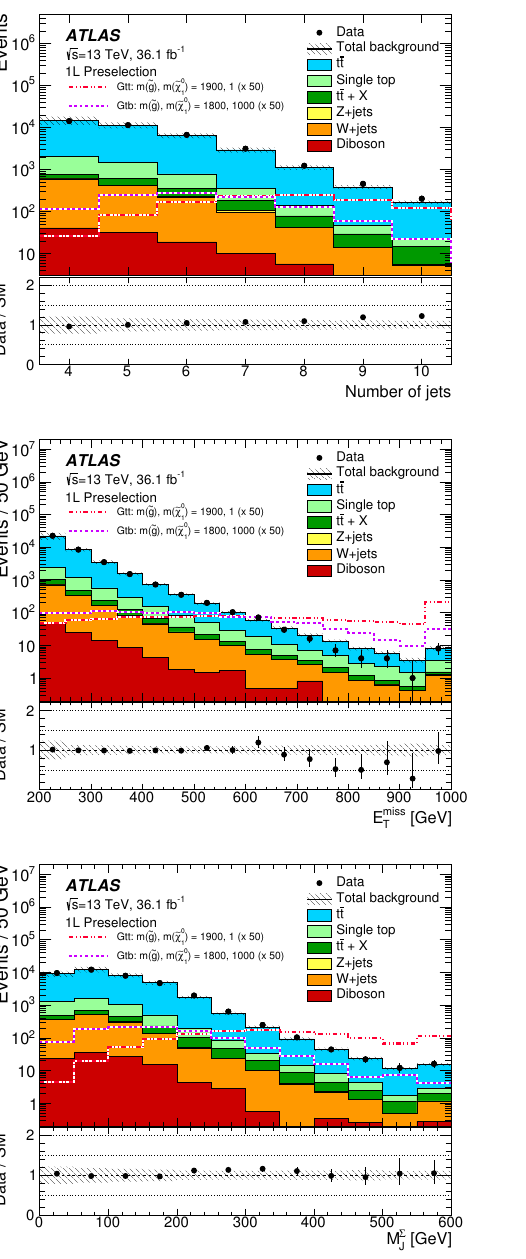
Figure 4. Distributions of (top-left) the number of selected jets ( N jet ), (top-right) the number of selected b -tagged jets, (centre-left) E miss , (centre-right) m e(cid:11) , (bottom-left) M (cid:6) and (bottom-right) J T m T for events passing the 1-lepton preselection criteria, after applying the kinematic reweighting to the m e(cid:11) distribution described in the text. The statistical and experimental systematic uncertainties (as de(cid:12)ned in section 7) are included in the uncertainty band. The last bin includes over(cid:13)ow events. The lower part of each (cid:12)gure shows the ratio of data to the background prediction. All backgrounds (including t (cid:22) t ) are normalised using the best available theoretical calculation described in section 4. The background category t (cid:22) t + X includes t (cid:22) tW=Z , t (cid:22) th and t (cid:22) tt (cid:22) t events. Example signal models with cross-sections enhanced by a factor of 50 are overlaid for